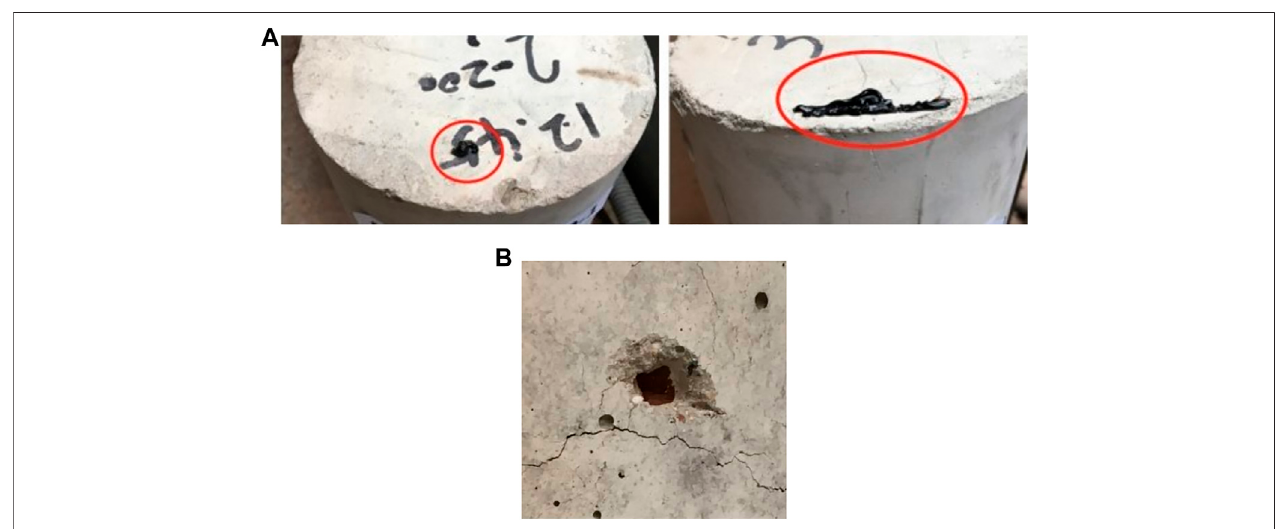
FIGURE 8 | (A) Melting rubber escaping through pores and cracks; (B) Spalling on the surface of RAC after high-temperature treatment (600 ° C).